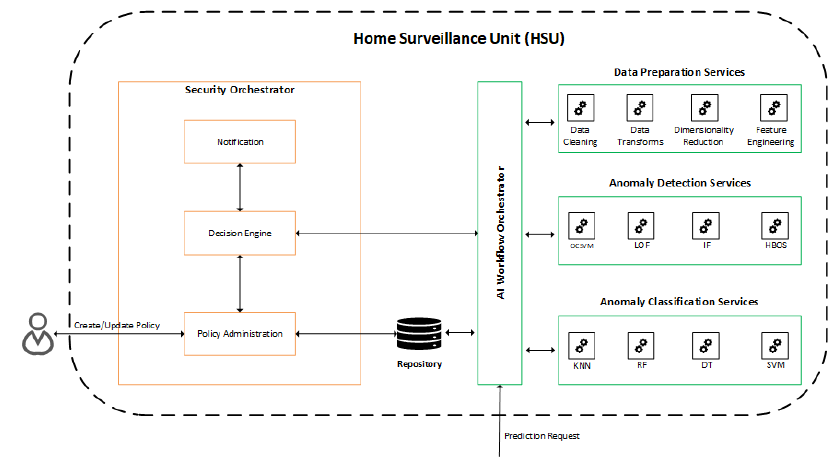
Figure 3. Communication between the services present in the